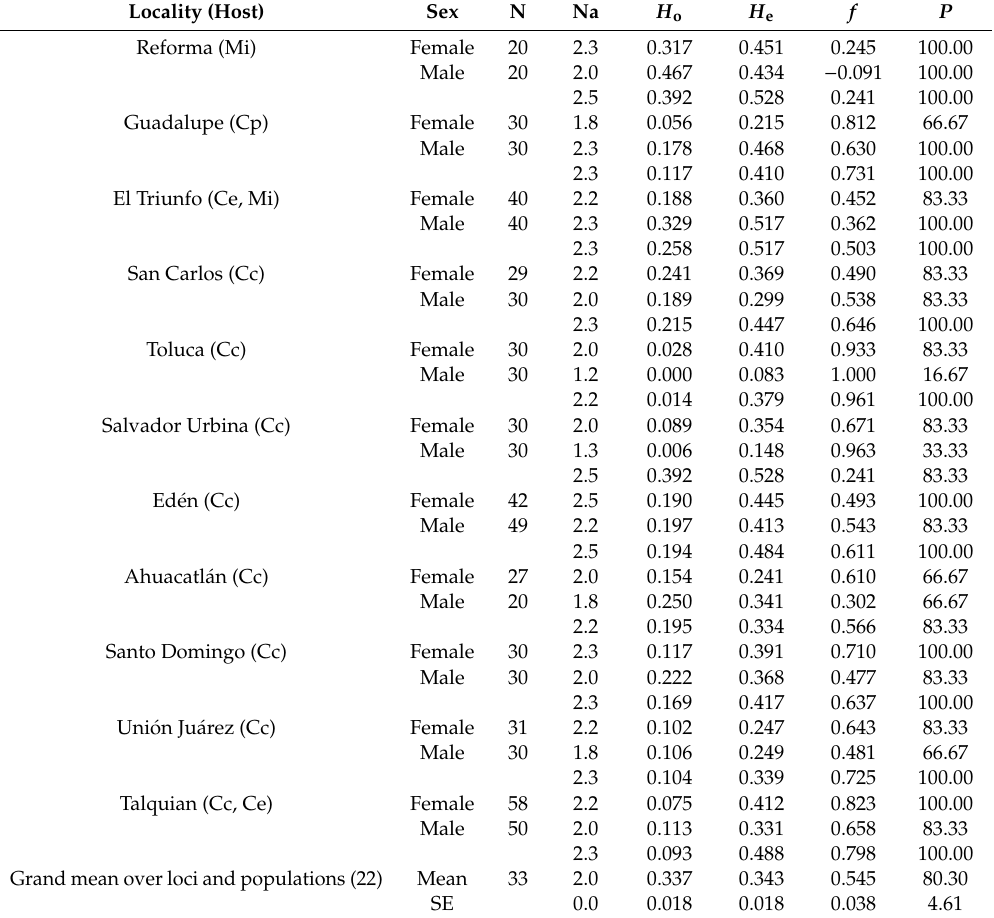
Table 2. Genetic diversity estimators for samples of males and females of Anastrepha ludens per locality and for the whole sample (female and male) from 11 localities in the Soconusco region, Chipas, Mexico. N, sample size; Na, average number of alleles; Ho , observed heterozygosity; He , expected heterozygosity; f , fixation index; P, percentage of polymorphic loci. Mi, Mangifera indica ; Cp, Citrus paradisi ; Ce, Casimiroa edulis ; Cc, Citrus sinensis.